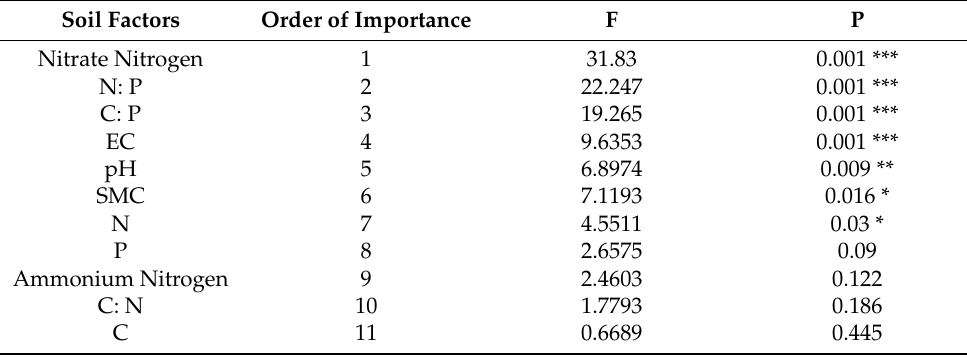
Figure 4. Redundancy analysis (RDA) of the moss crusts stoichiometric characteristics and its un- derlying soil physicochemical characteristics. In the biplot, the red lines in the figure represent the soil physicochemical characteristics, and the blue lines represent the moss crust C: N: P stoichiome- try, respectively. Notes: * p < 0.05, ** p < 0.01, and *** p < 0.001, SMC = soil moisture content, EC = electrical conductivity. Table 4. Importance ordering and significance test of soil variables (Moss